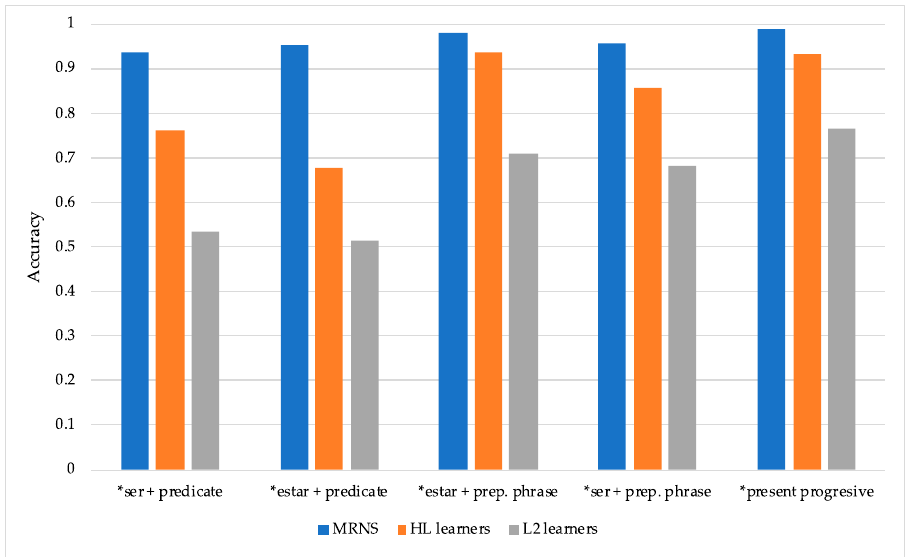
Figure 3. GJT: Mean accuracy ratings on ungrammatical sentences.